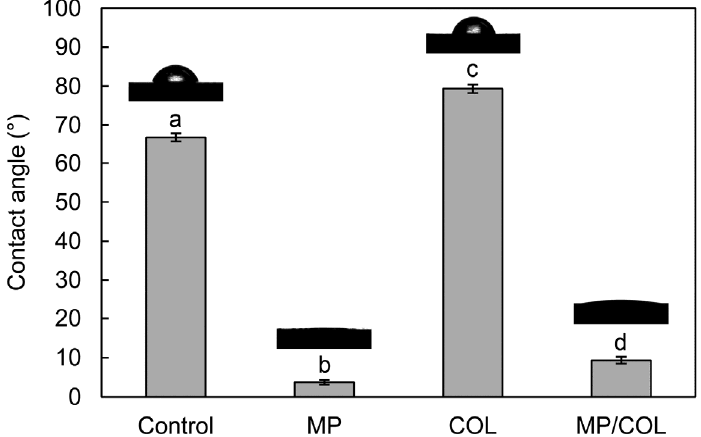
Figure 2. Contact angles of a drop of water on the four different surfaces. Identical lower-case letters indicate statistically equivalent values ( p > 0.05).